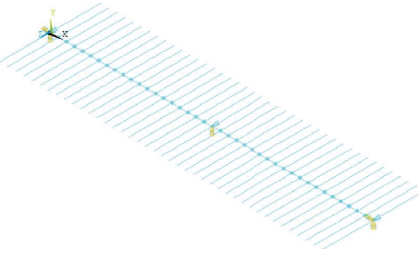
Figure 2: Initial fnite